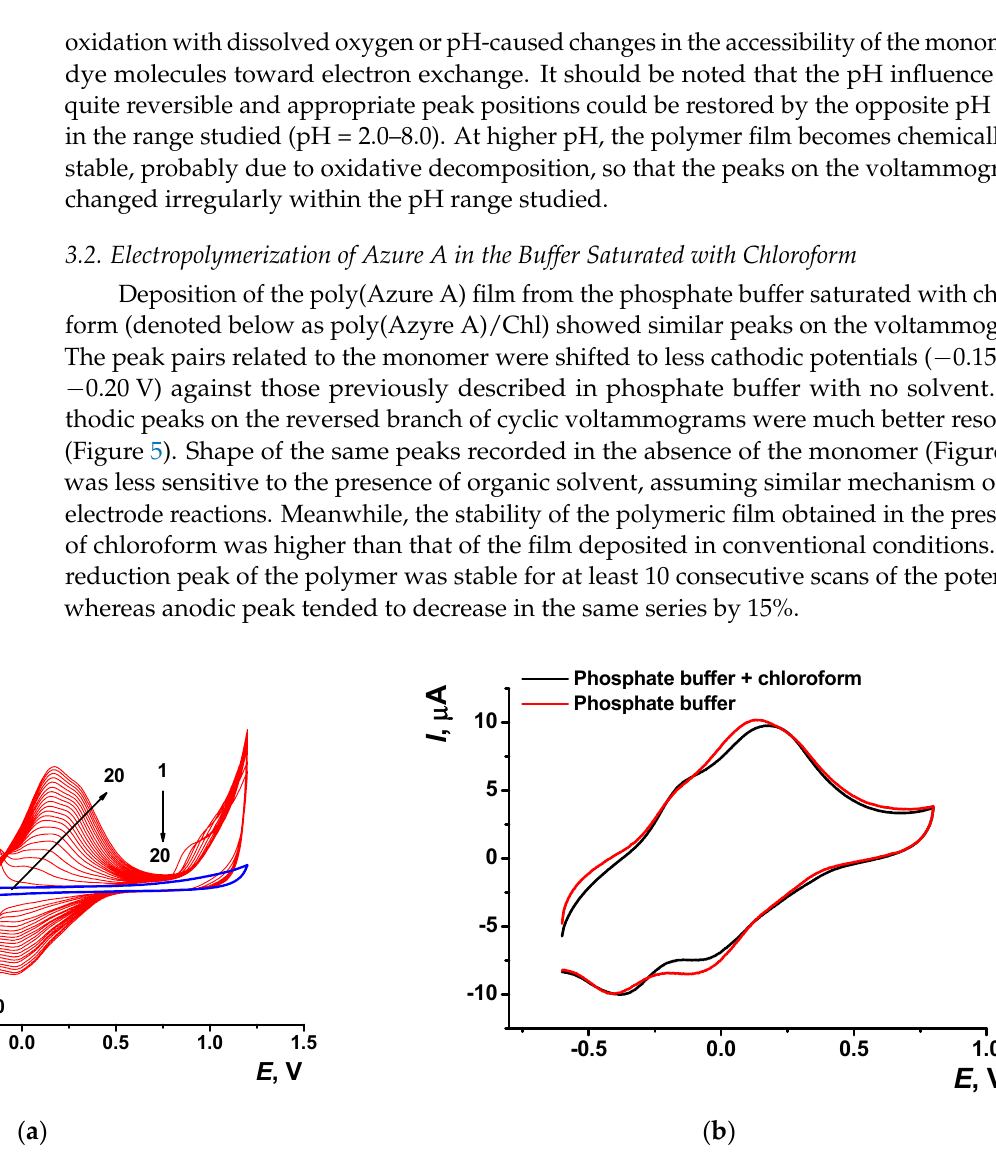
Figure 5. ( a ) Multiple cyclic voltammograms recorded on the GCE in 0.1 M phosphate buffer containing 0.1 M NaNO 3 and 0.2 mM Azure A and saturated with chloroform, pH = 7.0; scan rate 100 mV/s. Arrows indicate changes in the peaks from the 1st to 20th cycle, blue line corresponds to bare GCE. ( b ) Single cycle recorded on the GCE covered with poly(Azure A) transferred in the same buffer with no monomer dye.